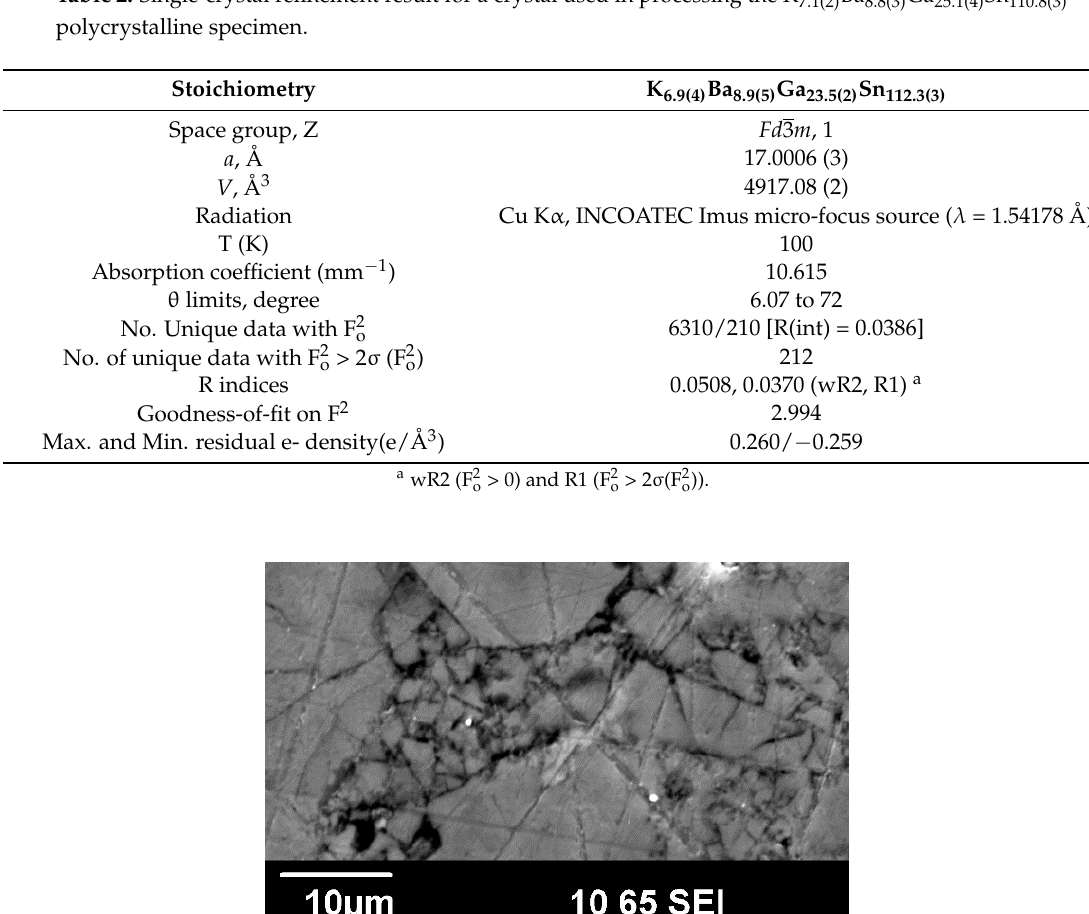
Table 2. Single-crystal refinement result for a crystal used in processing the K 7.1(2) Ba 8.8(3) Ga 25.1(4) Sn 110.8(3)